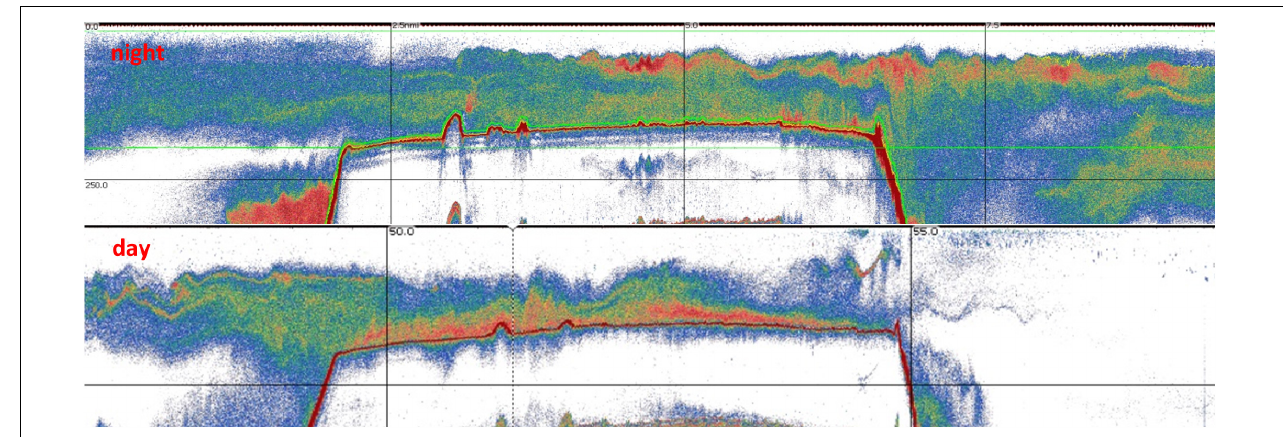
FIGURE 7 | Sv (volume backscattering strength) echograms at 70 kHz of two adjacent transects conducted at night (top) and day (bottom) at the McNish